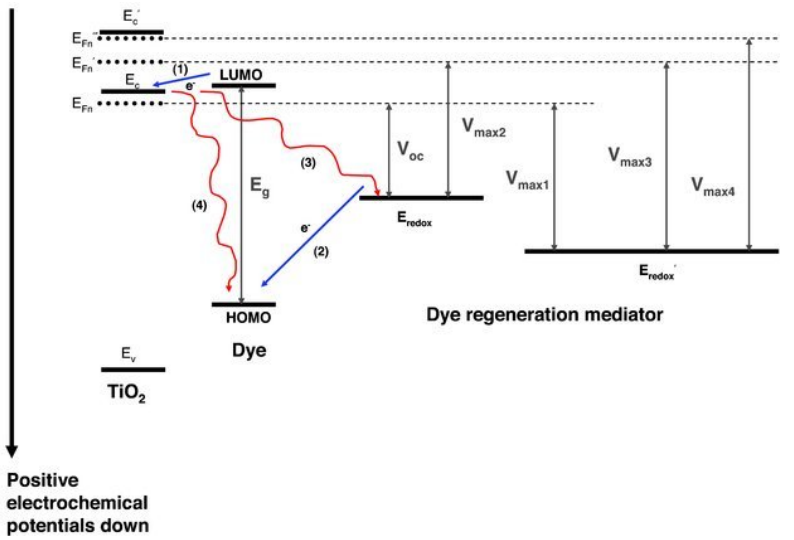
Figure 1. Processes occurring in DSSC: (1) electron injection, (2) dye regeneration, (3) recombination by electrolyte and (4) dye. Reprinted from [1] with permission from John Wiley and